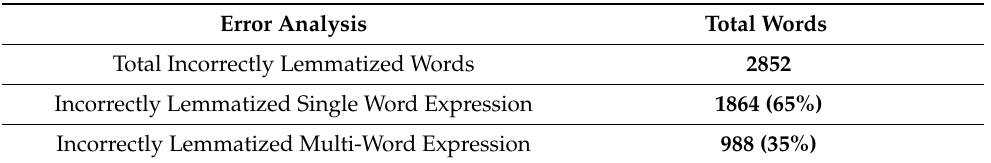
Table 7. Error analysis of the with-PoS-DLA approach with respect to the single-word and multi-word expressions.